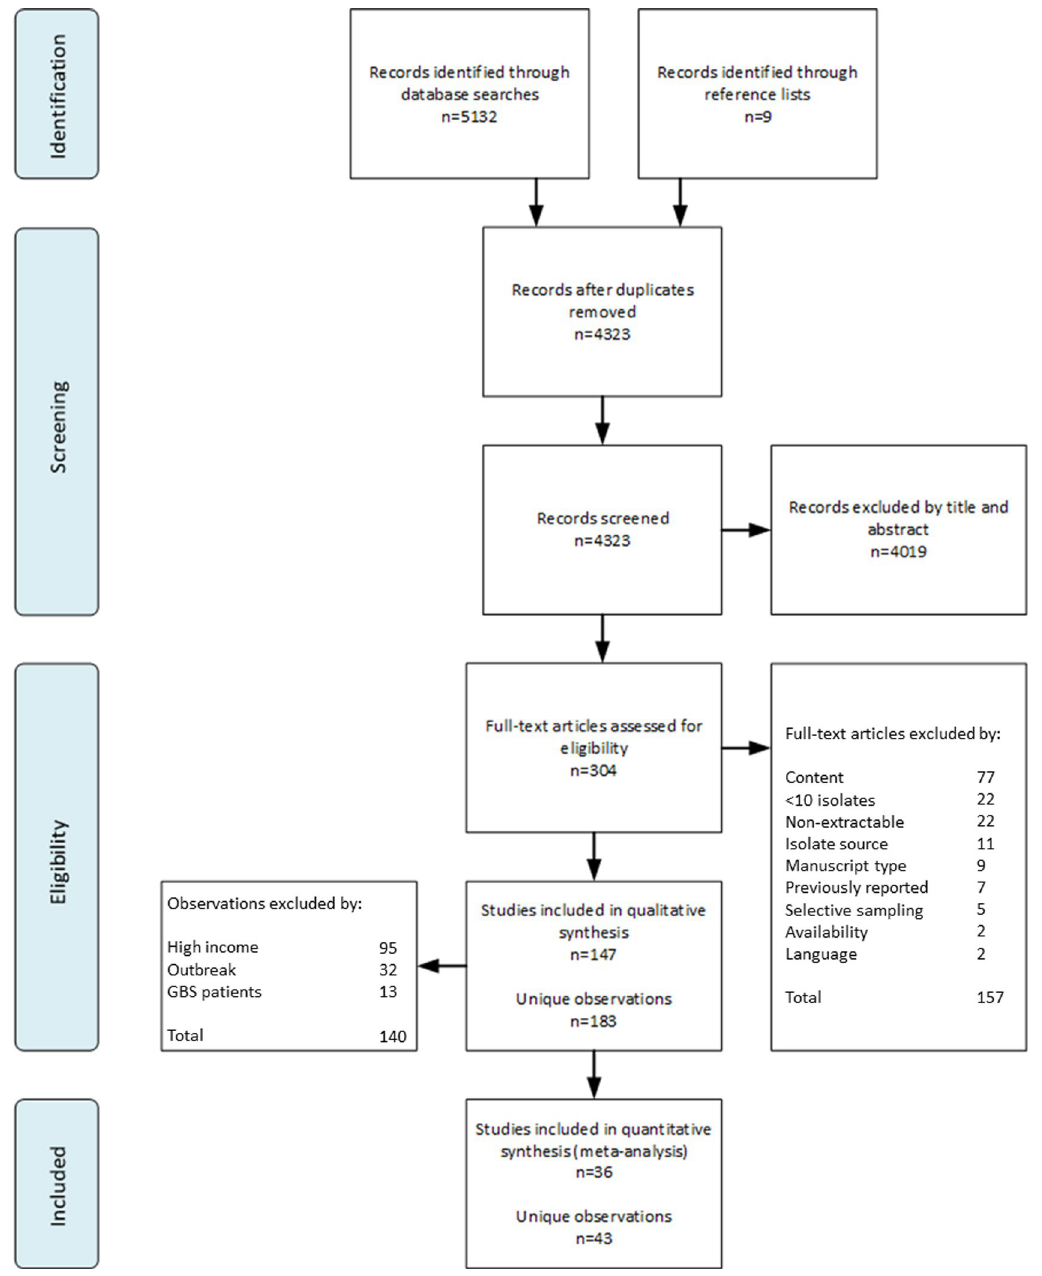
Fig 1. PRISMA flow diagram for identification and selection of included